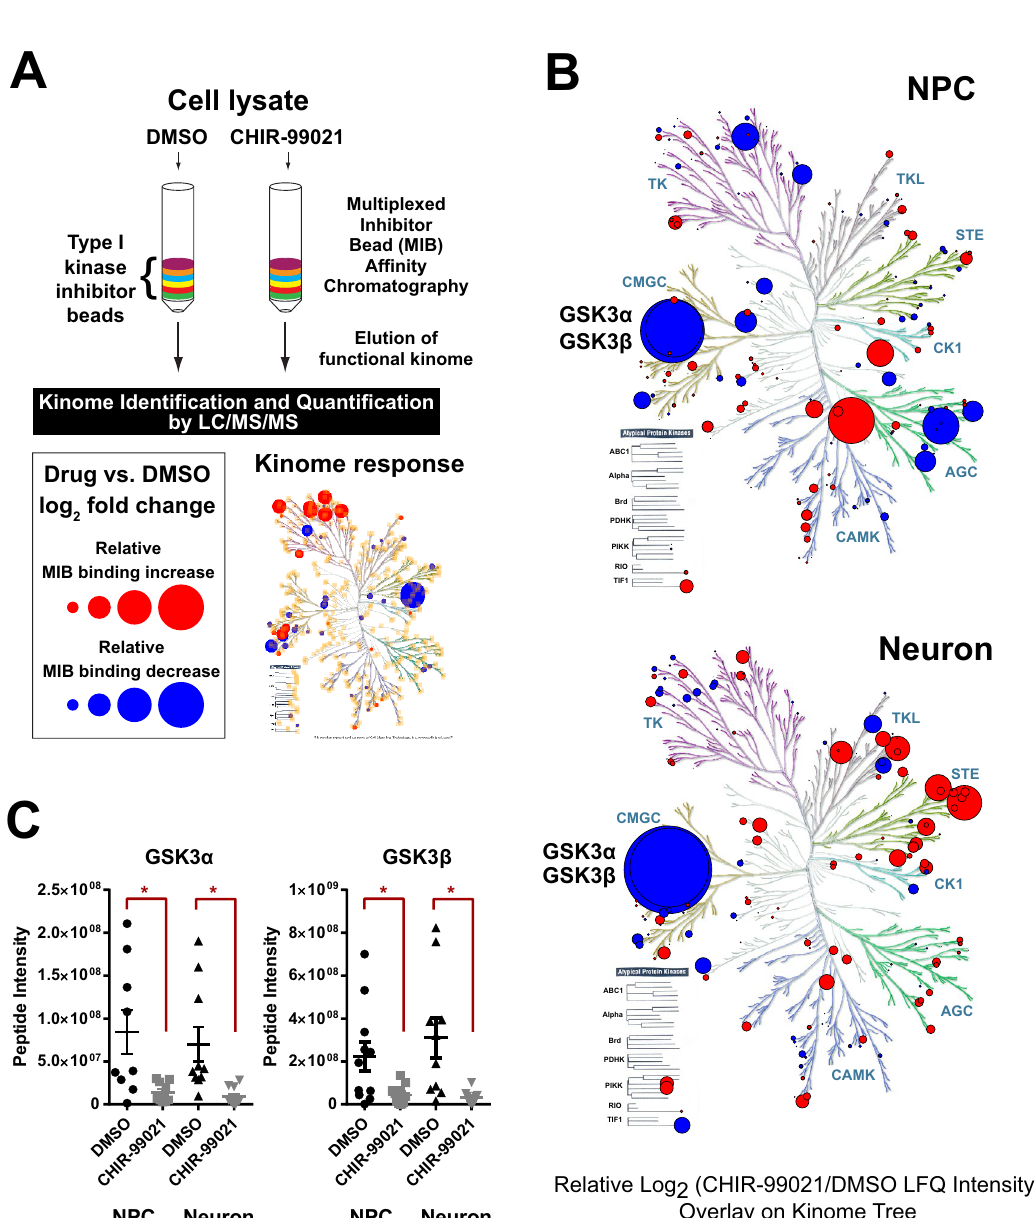
Figure 5. Effect of CHIR-99021 on the kinome in human NPC and neurons. ( A ) Schematic of the MIB-MS (Multiplexed Inhibitor Bead matrix followed by Mass Spectrometry) methodology. ( B ) Response of kinases in NPC and iNgn2 neurons to 24 h treatment with CHIR-99021 (1 μM) represented in a kinome tree. Magnitude of the LFQ intensity is represented by the sizes of the dots in the kinome tree; blue dots represent negative values and red dots represent positive values. ( C ) Scatter dot plot of GSK3α and GSK3β peptide intensity from mass spectrometry in NPC or neurons with CHIR-99021 (1 μM) or DMSO treatment. For each condition, the horizontal line represents the mean and the error bar represents SEM. Unpaired t-test with Welch’s correction was performed, *p < 0.05. Kinome trees produced using Kinome Render and illustration reproduced courtesy of Cell Signaling Technology, Inc. (www. cells ignal. com) 80